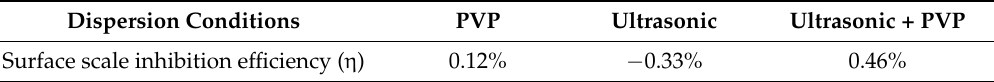
Table 1. The surface scale inhibition efficiency in different dispersion conditions.